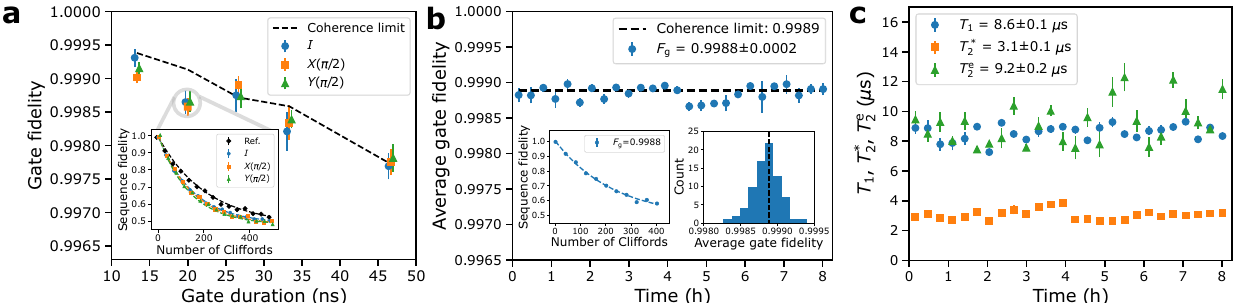
Fig. 4 | Implementation of fast and stable single-qubit gates for qubit B. a Average gate fi delity as a function of the gate duration for gates in the set { I , X ( π /2), Y ( π /2)}. The error bars represent the standard error of the mean based on six interleaved randomized benchmarking experiments. The dashed black line shows the coherence limit computed based on the mean values of the energy relaxation time T 1 and the echo coherence time T e 2 . The inset shows the results of an exemplary interleaved randomized benchmarking experiment corresponding to a gate duration of 20 ns. b Average gate fi delity F g measured withrandomizedbenchmarking asafunctionoftime lapsed fromthe initialgate and parameter calibration. The error bars represent the standard error of the